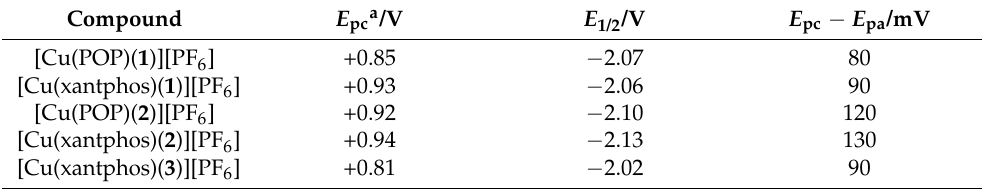
Table 2. Copper(I)/(II) oxidation potentials in the copper(I) compounds. Propylene carbonate solutions (ca. 10 − 4 mol dm –3 ); values are referenced internally to Fc/Fc + = 0.0 V; [ n Bu 4 N][PF 6 ] as supporting electrolyte and scan rate of 0.1 V s –1 .